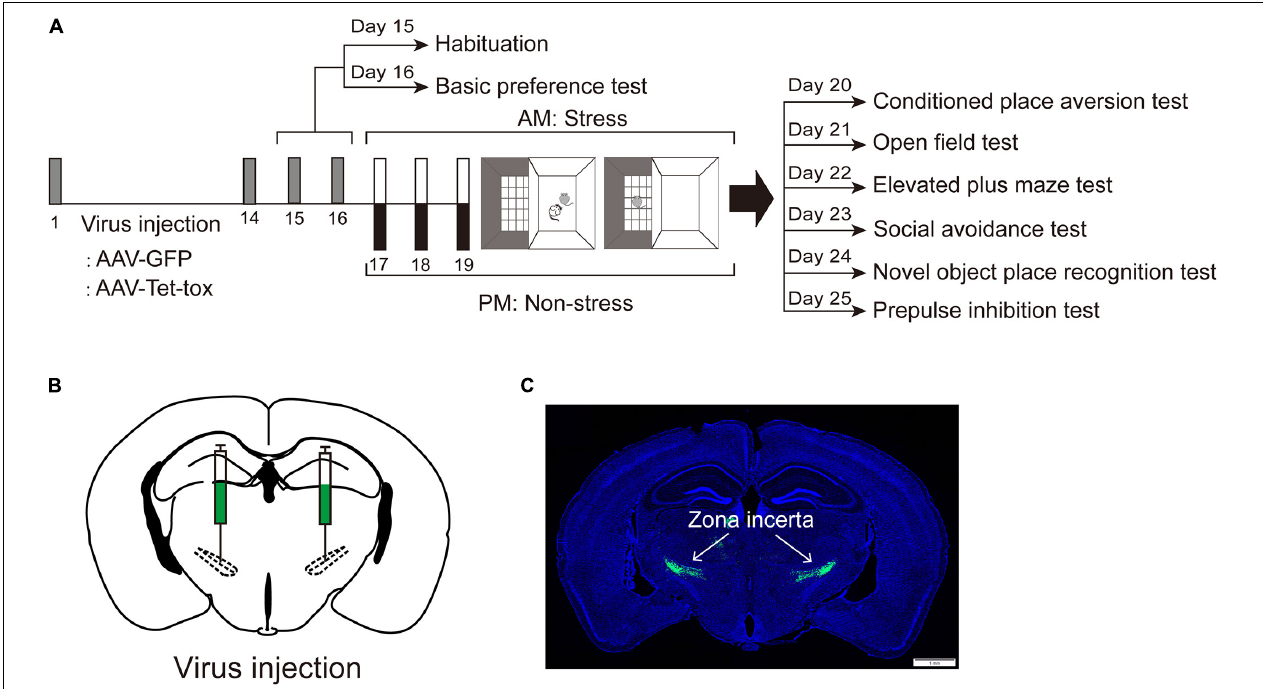
FIGURE 1 | Experiment timeline. (A) Experiment timeline. Mice were infected with AAV-GFP or AAV-Tet-tox in the ZI, 2 weeks after the expression of AAV, mice were received a 3 days of conditioned social defeat training. The CPA test, OFT, EPM test, social avoidance test, NOPR test, and PPI test were performed, respectively, after the last training day. (B,C) Virus injection sites and expression